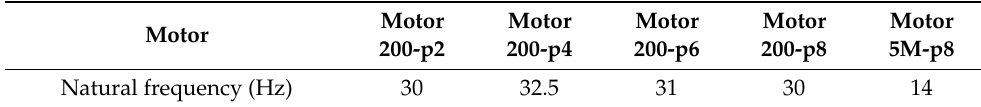
Table 2. Natural frequencies of the first elastic mode.